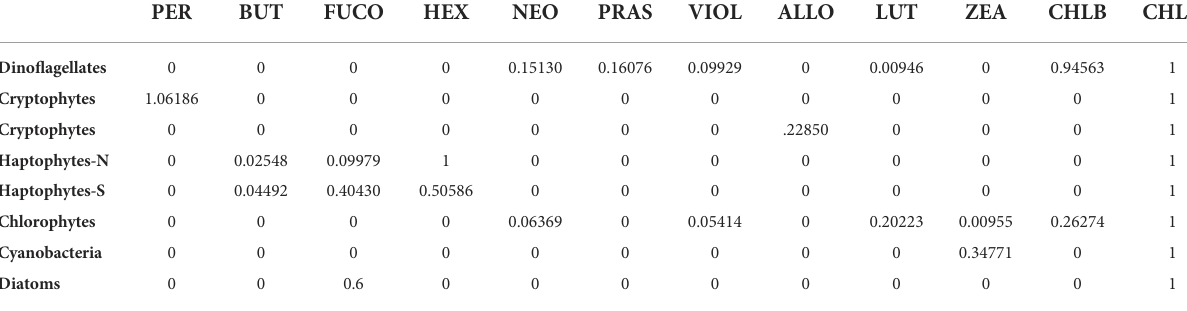
TABLE 1A Initial CHEMTAX pigment ratios adopted from Wright et al. (1996).